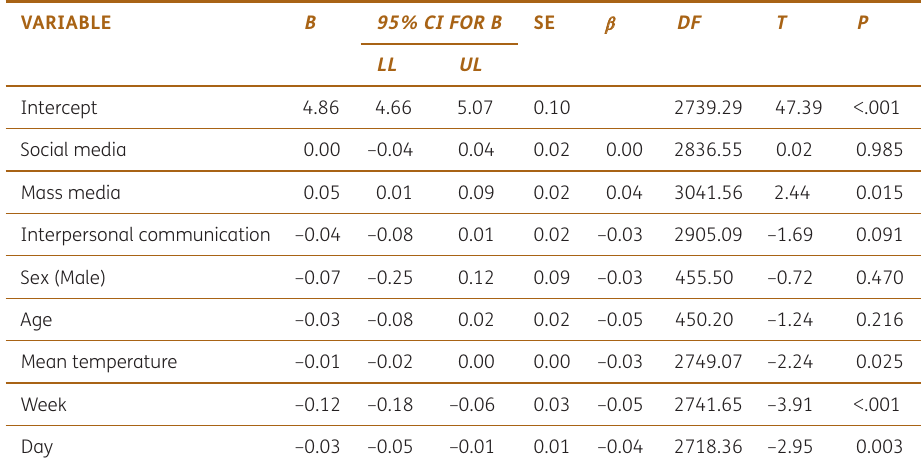
Table 6 Multivariate Linear Mixed-Effects Model Predicting Physical Distancing Behavior in the School Sample. Note : N = 460. ICC = .61. Marginal R 2 = .01. Conditional R 2 = Participant